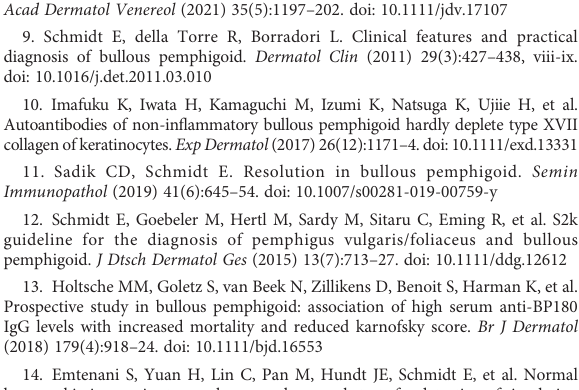
(n=10), and BP perilesional skin (n=10). Plots were based on normalized and log2 transformed FPKM values and the identi fi cation of differentially